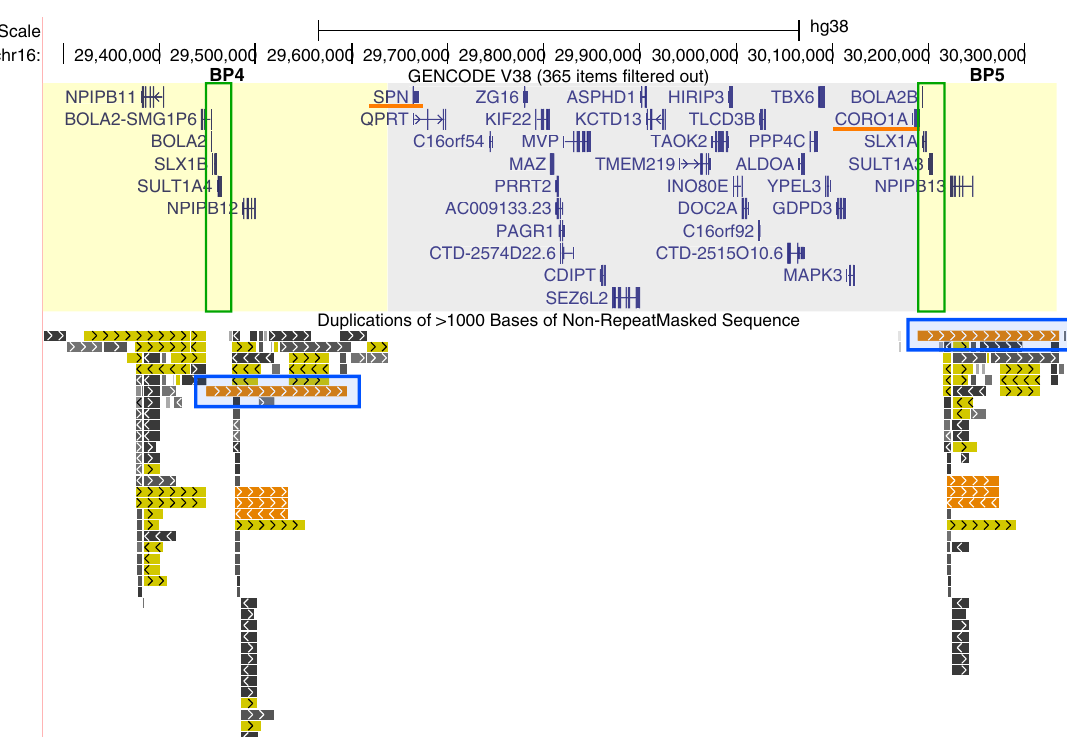
Fig. 1 UCSC genome browser view of the 16p11.2 BP4-BP5 region. The GENCODE Genes (protein-coding genes, version 38) and Segmental Dups tracks are shown (genome assembly hg38). The single-copy region (~600 kbp in size, gray background) is present in n = 2 copies per diploid genome in euploid individuals, n = 1 copy in deletion carriers, and n = 3 copies in duplication carriers. Among the 30 protein-coding genes that map to this interval, SPN and CORO1A have known roles in leukocyte biology (underlined in orange). In the fl anking segmental duplication clusters (yellow background), 10 protein-coding genes map and include paralogous copies of NPIPB , BOLA2-SMG1P , BOLA2 , SLX1 , and SULT1A . A high-identity duplication pair (highlighted by blue rectangles) generates the 16p11.2 BP4-BP5 CNV through non-allelic homologous recombination. The copy-number variant BOLA2 duplicon (range: 3 – 8 copies per diploid genome) is marked by a green rectangle and contains BOLA2/2B , SLX1A/B , and SULT1A3/4 genes. The scale bar corresponds to 500